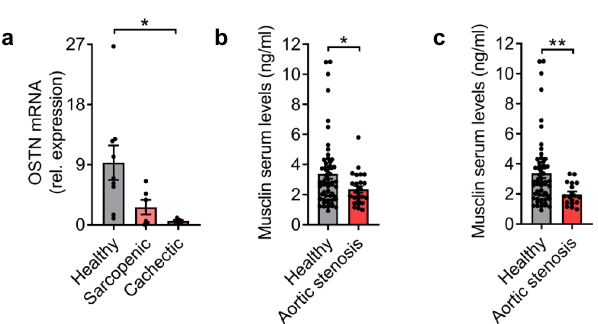
Fig. 2 Muscle OSTN mRNA and Musclin serum levels are reduced in patients with heart failure. a OSTN mRNA levels in vastus lateralis muscle biopsy samples from control individuals ( n = 9) and from patients with sarcopenia ( n = 6) or cachexia ( n = 5), * p = 0.0236. b Concentrations of Musclin protein in the serum of healthy control individuals ( n = 56) and of patients with severe aortic stenosis ( n = 26), * p = 0.0403 ( c ) and of the same patients excluding the ones with diabetes mellitus ( n = 18), ** p = 0.0044. Data are shown as mean ± standard error of the mean (SEM). * p < 0.05, ** p < 0.01 as determined by ANOVA followed by the Holms – Sidak ’ s multiple comparisons test ( a ) and the two-tailed Mann – Whitney test ( b , c ). Source data are provided as a source data fi